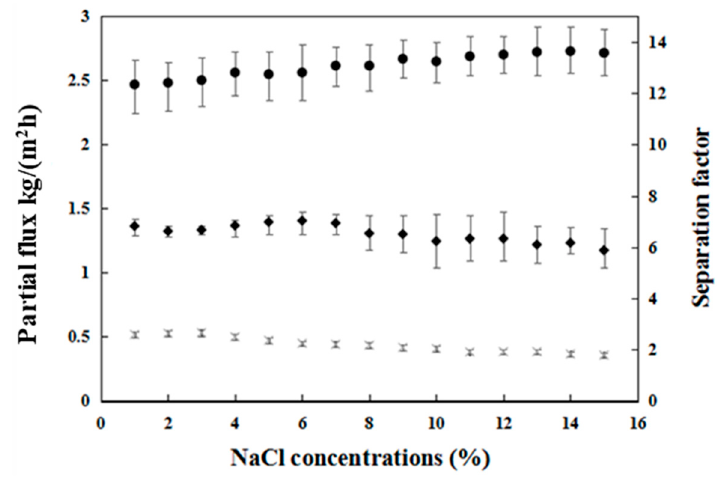
Figure 8. The effect of NaCl concentration on the initial ( ∆ t = 0–10 min) partial permeate flux and separation factor in ethyl acetate/water/NaCl solution: ( ◆ ) ethyl acetate flux, (×) water flux, and ( ● ) separation factor.